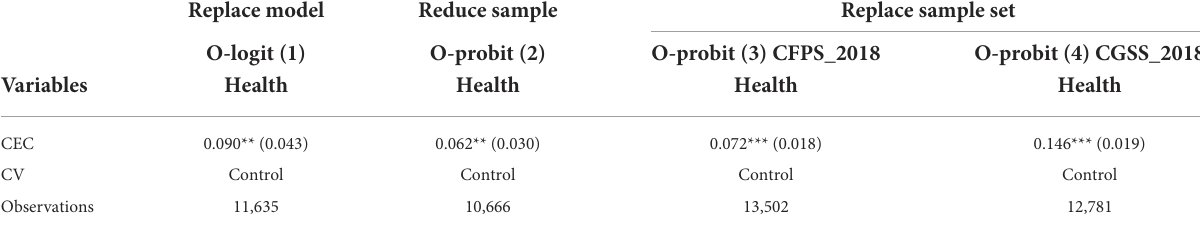
TABLE 4 The results of robustness test of CEC and